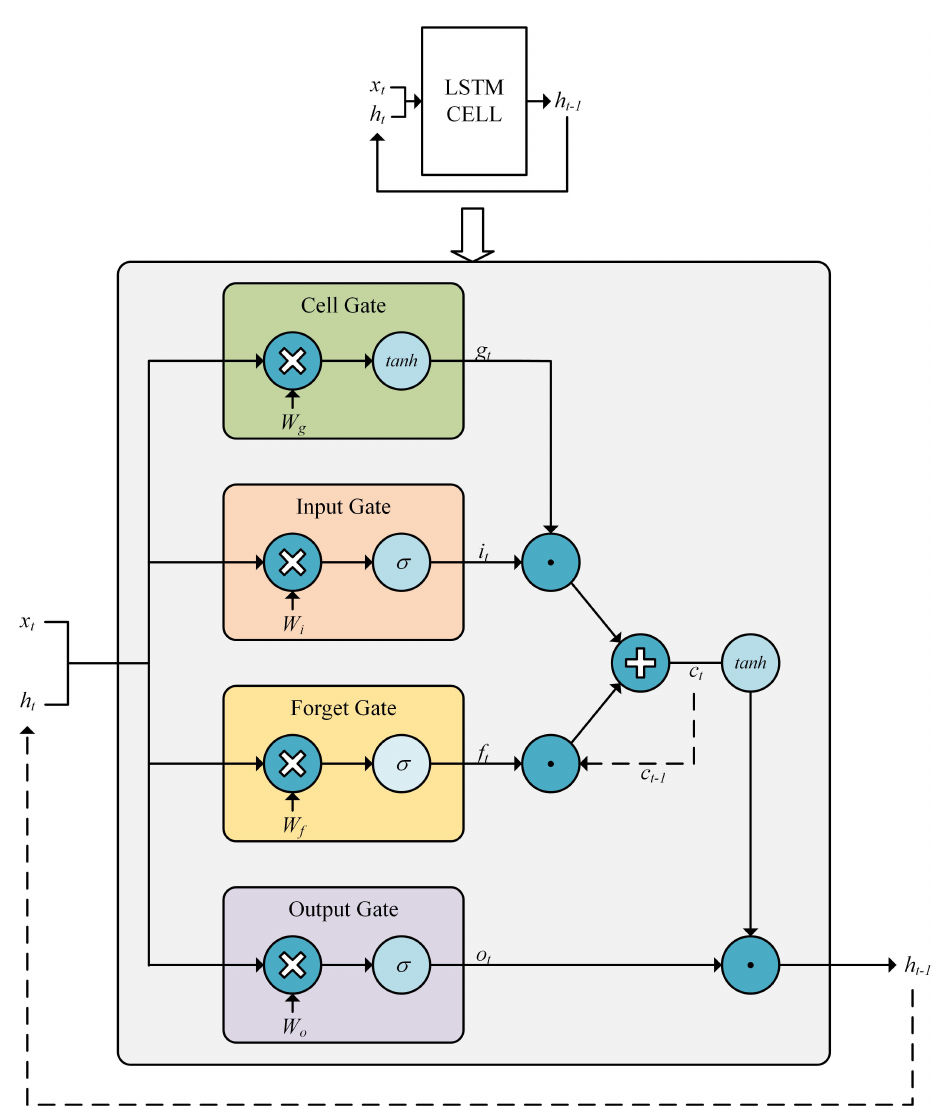
Figure 1. Structure of LSTM cell. σ denotes the sigmoid function, tanh denotes the hyperbolic tangent function, × denotes matrix-vector multiplication, + operator denotes elementwise addition, and operator (cid:12) denotes elementwise